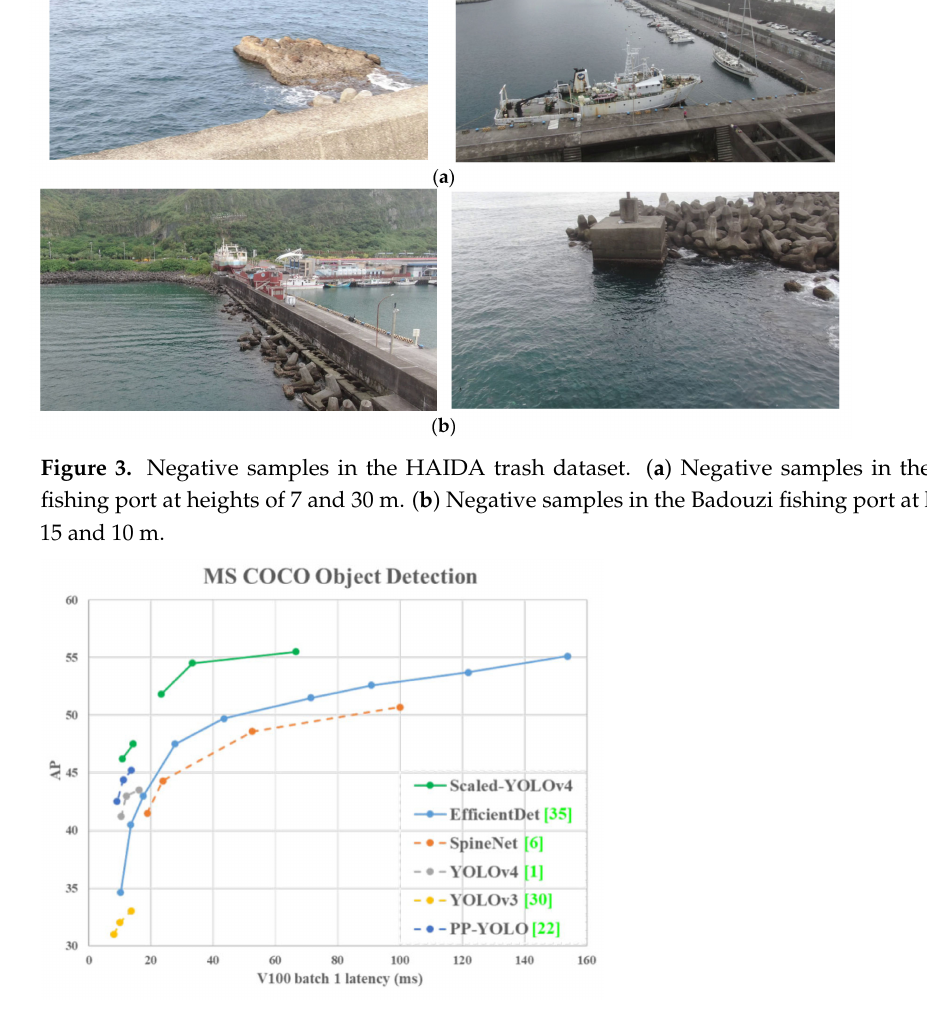
Figure 4. Comparison of state-of-the-art object detectors on the MS COCO dataset, C.Y. Wang 2020. The backbone of YOLOv4-Tiny is CSPOSANet, which is inspired by CSPNet and VoVNet [31]. In VoVNet, the authors proposed a one-shot aggregation (OSA) module that concatenated all features only once in the last feature map to resolve the heavy memory cost (MAC) and the inefficiency of the computation of DenseNet [21], as shown in Figure 5.